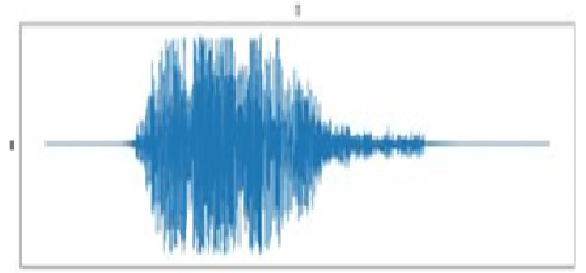
Fig. 9. Dog spectrogram with distortion (audio clip containing external